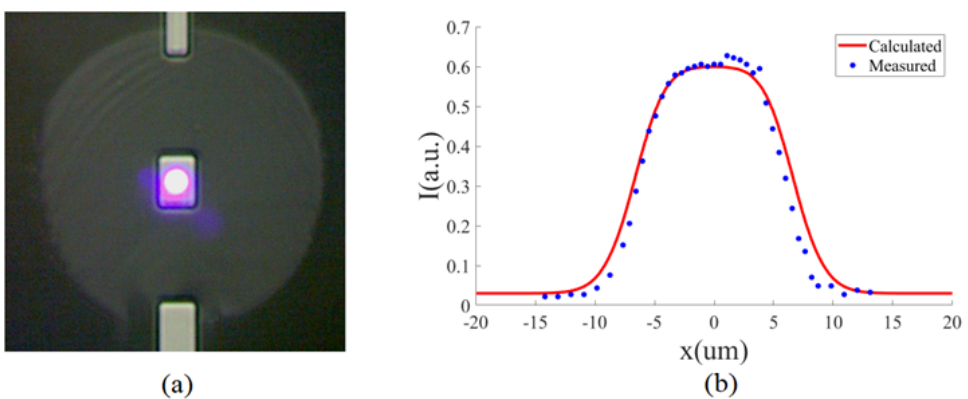
Figure 7. Experimental verification of alignment by reflected wave intensity measurement. ( a ) Image of a 15 µ m × 20 µ m dummy sensor fabricated on a transparent quartz substrate, and that of the beam spot of the fiber when it is aligned with the sensor by reflected wave intensity measurement, photographed using the verification system in Figure 6. ( b ) Measured reflected wave intensity and calculated curve based on Equation (20), against misalignment along the midline of the device, representative of the degree of agreement between experimental data and numerical